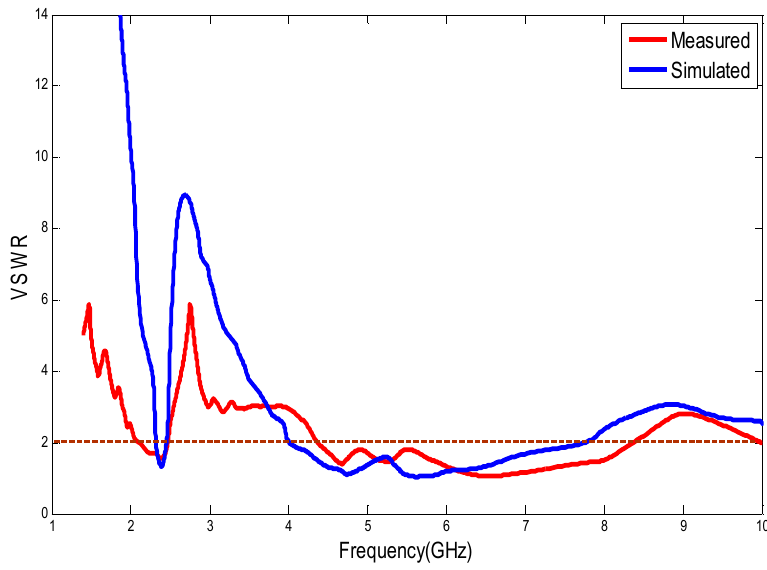
Figure 14. Simulated and measured VSWR of the proposed antenna.